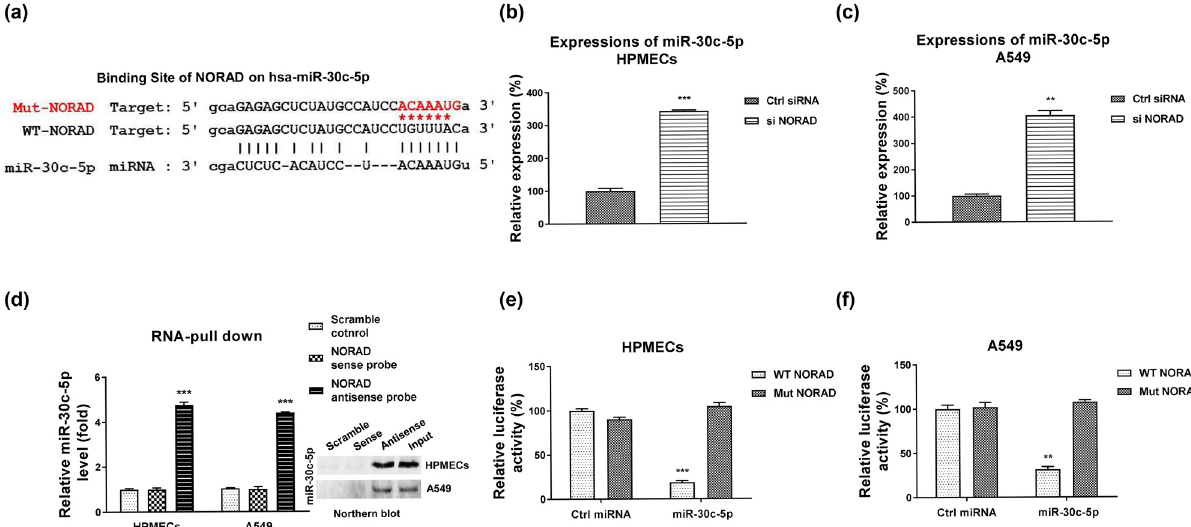
Figure 3: NORAD sponges miR - 30c - 5p in HPMECs. ( a ) Prediction of the binding of miR - 30c - 5p on NORAD from starBase. ( b ) HPMECs and ( c ) A549 cells were transfected with control siRNA or si NORAD. Expressions of miR - 30c - 5p were examined by qRT - PCR. ( d ) RNA pull - down assay was shown in HPMECs by incubation of biotin - labeled control, sense, or antisense NORAD probe with cell lysates. Enrichment of miR - 30c - 5p in the RNA complex was determined by qRT - PCR and Northern blot. ( e ) HPMECs and ( f ) A549 cells were transfected with control miRNA or miR - 30c - 5p with luciferase vector containing WT - or MUT - NORAD. Luciferase assay was performed. **, p < 0.01; ***, p <